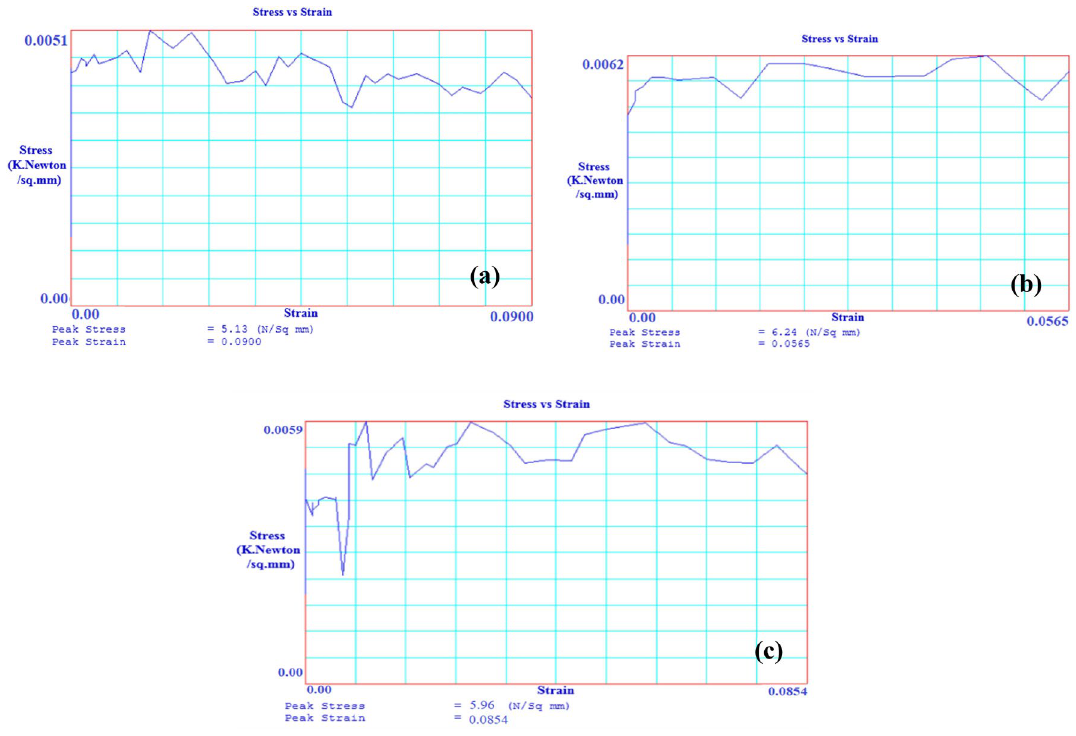
Figure 9. Image of stress v/s strain graph ( a ) S1, ( b ) S2, ( c ) S3.